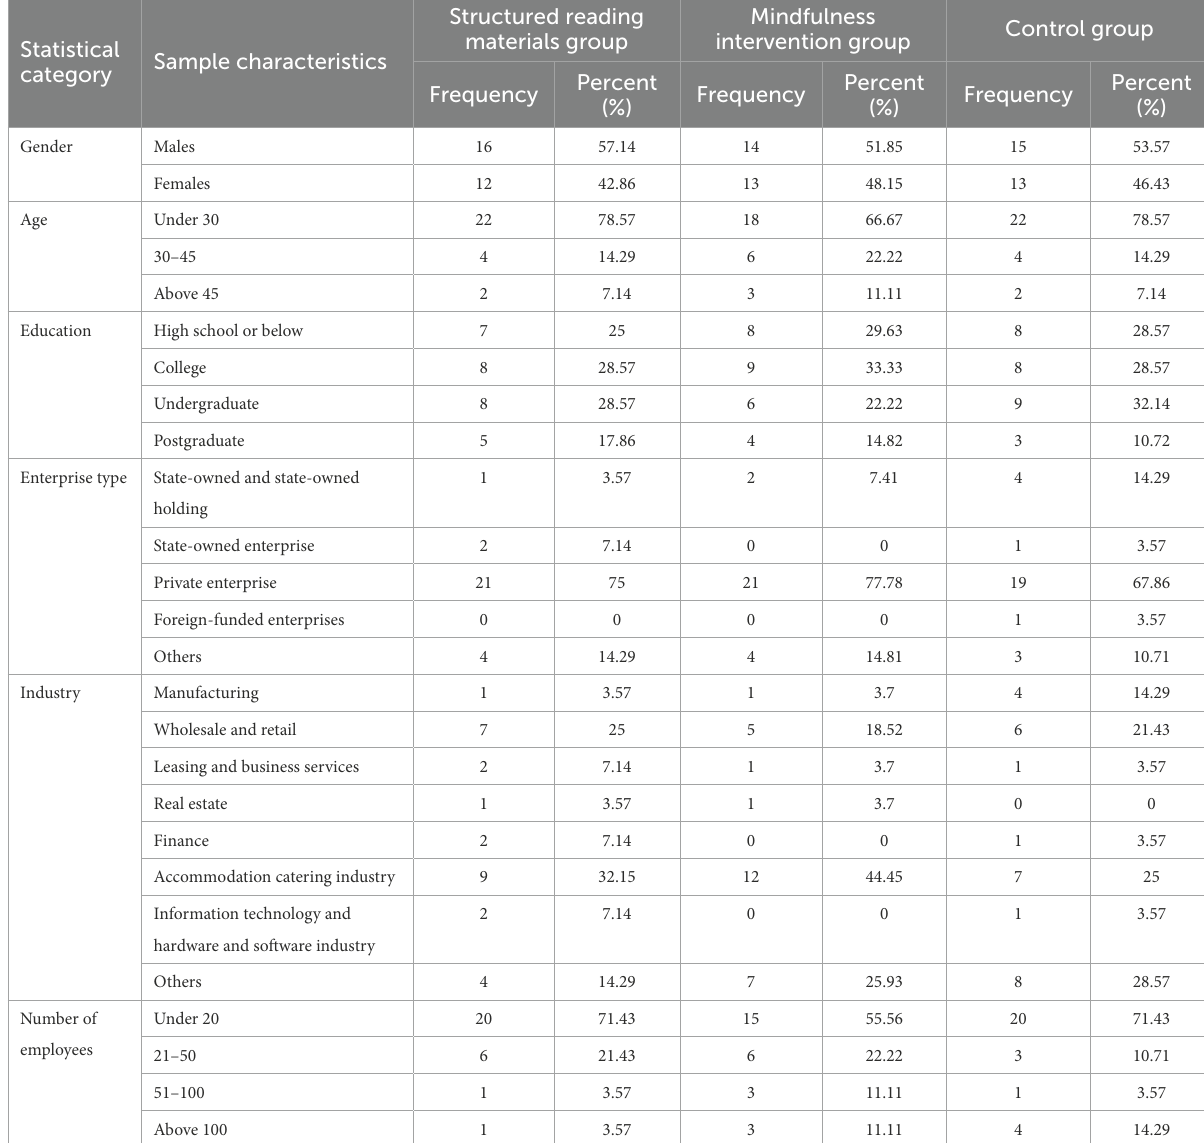
TABLE 1 Descriptive characteristics of the sample.